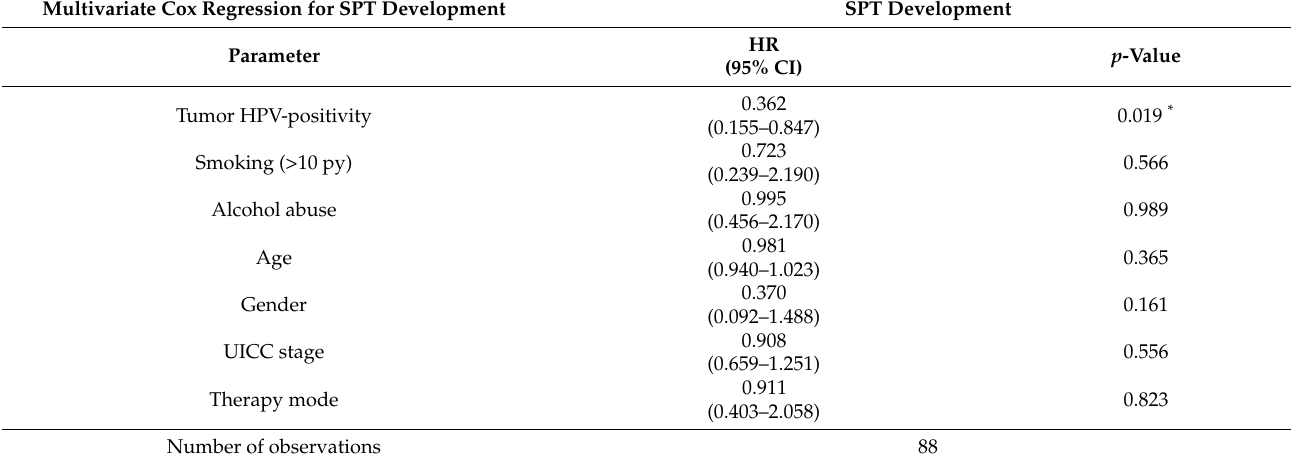
Table 3. Multivariate Cox regression for SPT development. Table 3 shows the results of the multivariate Cox regression of SPT (0 = no SPT, 1 = SPT) on the independent variables of tumor HPV positivity (negative = 0, positive = 1), smoking status (0 = <10 py, 1 = ≥ 10 py), history of alcohol abuse (0 = no alcohol abuse, 1 = alcohol abuse), age (in years), sex (0 = male, 1 = female), UICC stage (1 = stage I, 2 = stage II, 3 = stage III, 4 = stage IVa, 5 = stage IVb), and therapy mode (0 = surgery only, 1 = RT ± chemo). * indicates statistical significance at the 5% significance level. Since alcohol use is unknown in three patients, 88 observations are included instead of 91. Abbreviations: Chemo = chemotherapy, CI = confidence interval, HR = hazard ratio, py = pack years, RT =radiotherapy, UICC = Union internationale contre le cancer. Multivariate Cox Regression for SPT